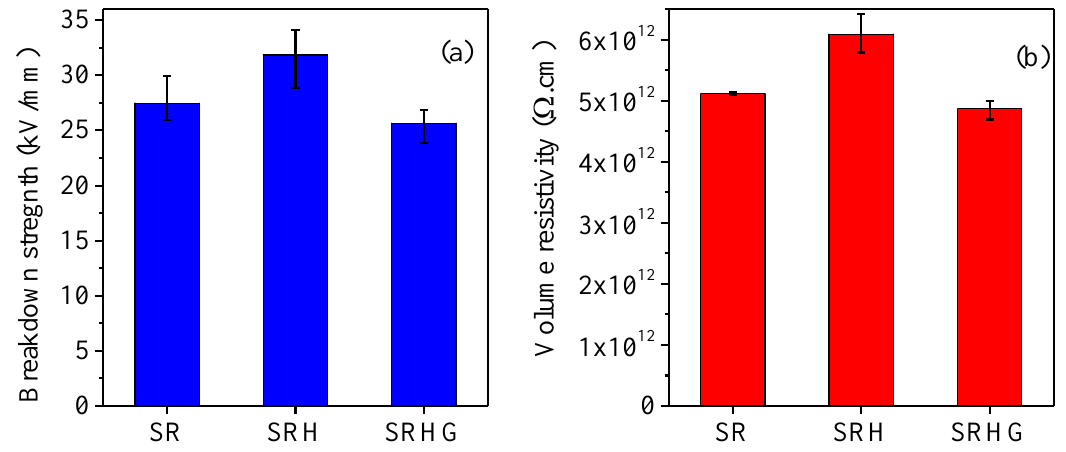
Figure 4. Results on ( a ) breakdown strength and ( b ) volume resistivity.